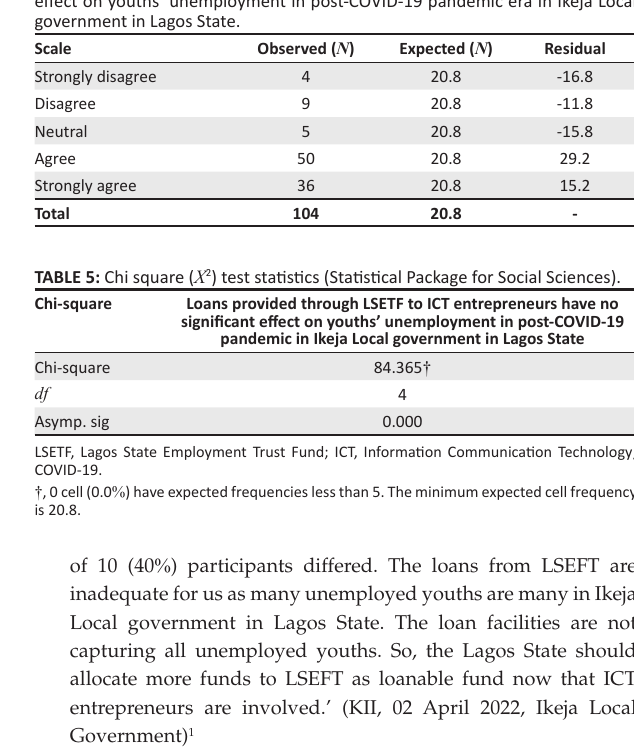
TABLE 4: H0: Loans provided by Lagos State Employment Trust Fund to Information Communication Technology entrepreneurs have no significant